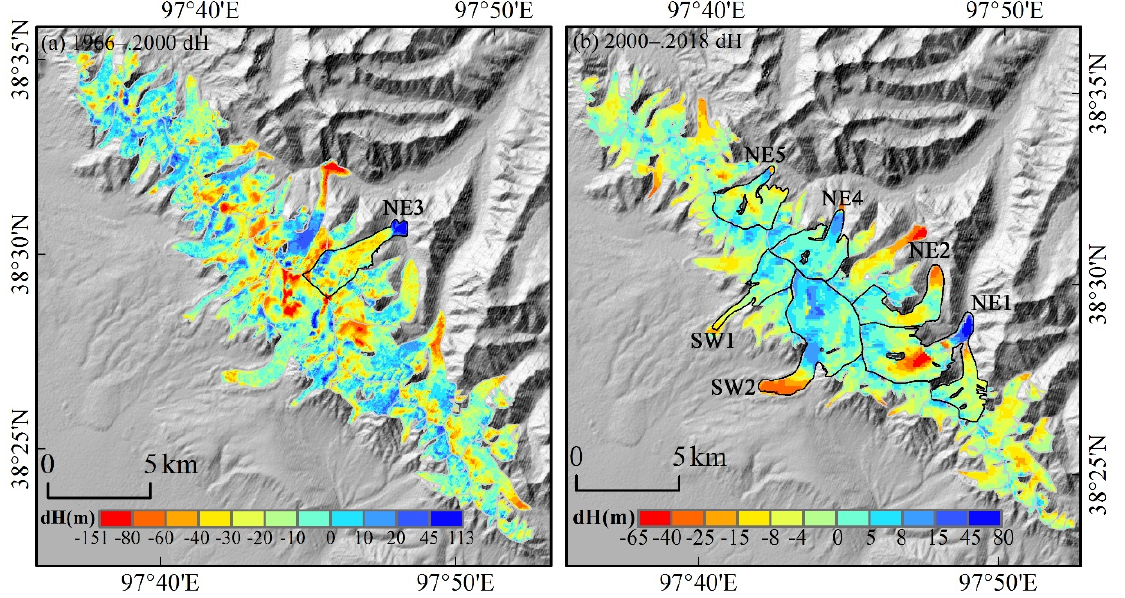
Figure 2. Elevation change of STGs using TOPO, the SRTM DEMs, and ASTER in the TJP. Reference Figure 1 for flowline location. Table 5. Mean surface elevation changes of the reservoir area and receiving area and transfer of ice volume for studied glaciers.